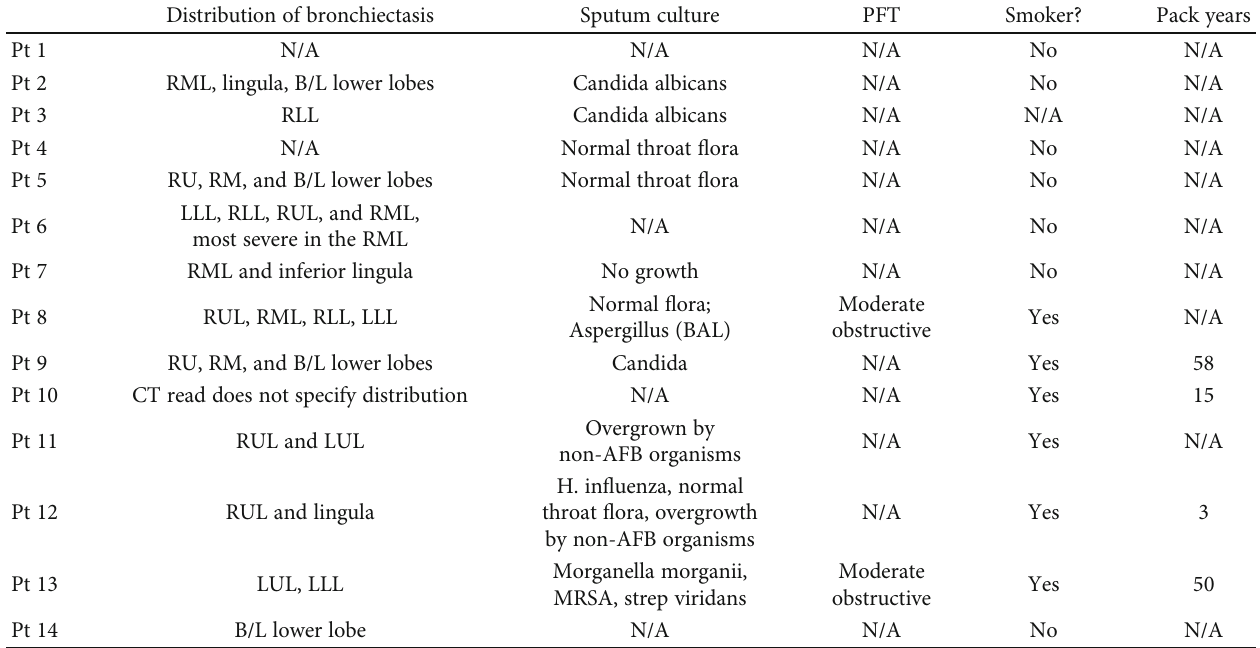
Table 2: Distribution of bronchiectasis and microbiology data. Distribution of